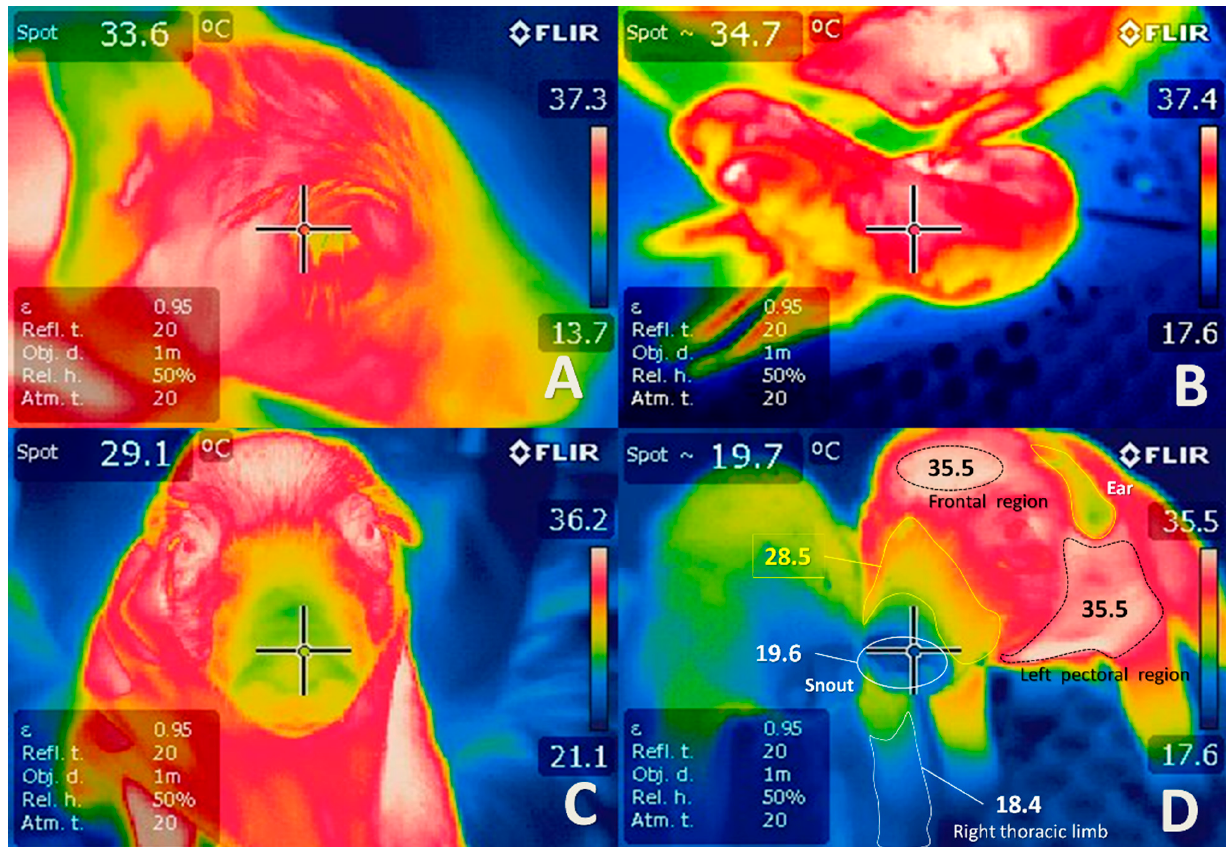
Figure 9 . Thermograms of newborn piglets with severe hypoxia and meconium staining on the skin to a severe degree. It is important to dry the newborn immediately, since the humidity of the amni ‐ otic fluid favors a rapid drop in body temperature. The areas marked in yellow on the thermograms indicate temperatures between 28 and 32 °C, especially in images ( A – C ), where a marked drop in temperature is seen in peripheral areas of the auricular pavilion, thoracic limbs, and especially the face, particularly the snout. In thermographic image ( D ), we can see a piglet stained with severe meconium grade, with umbilical ‐ cord rupture, a failing vitality score, and severe hypothermia, de ‐ spite having been dried. It is important to note that different temperatures are seen depending on the body region. In the frontal area of the head and left pectoral region, the highest surface temper ‐ atures are observed (35.5 °C). In yellow (image ( D )), the proximal region of the snout and the auric ‐ ular pavilion (28–29 °C) are distinguished, and in the distal region of the thoracic limbs and the distal snout area (in blue), the lowest temperature ranges of 18–19 °C are shown. The use of infrared thermography is essential to understanding the changes in the vascular microcirculation in the study of hypothermia in newborns with asphyxia.